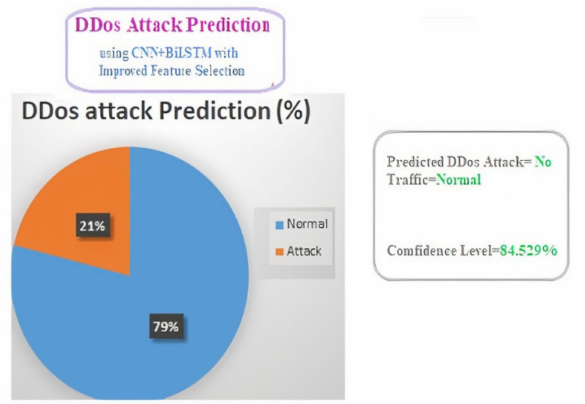
Figure 4. DDoS attack prediction